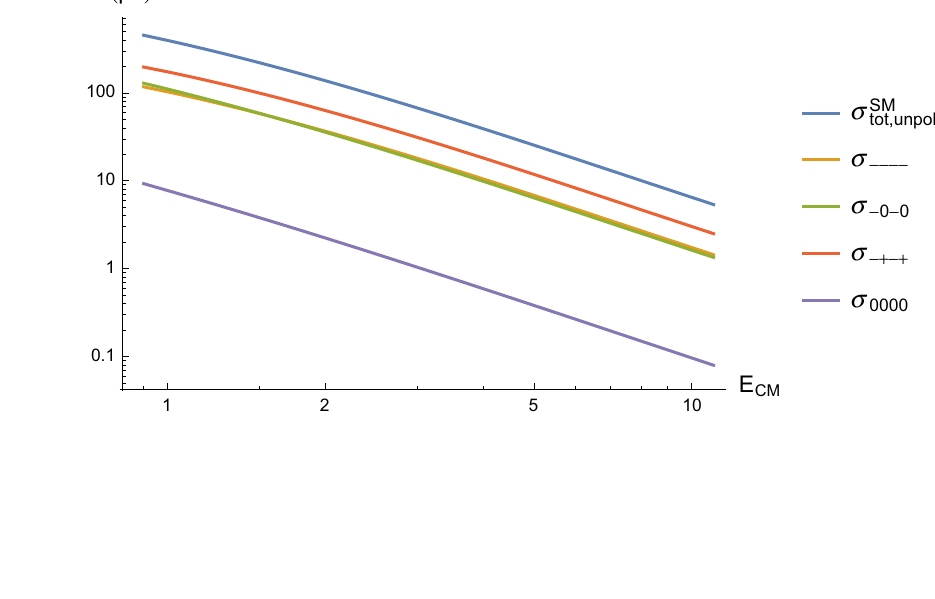
Fig. 7 Illustration of the contributions of different helicities (multiplicity taken into account) to the total unpolarized cross section as a function of the center-of-mass collision energy √ s , in TeV) in the SM. ( E CM ≡ The total cross section is shown in